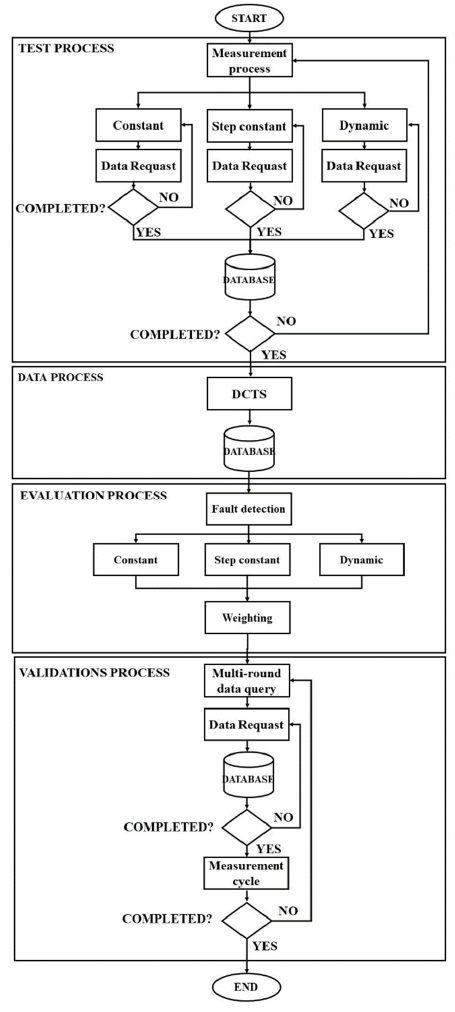
Figure 1. Faulty cell detection and localization algorithm.